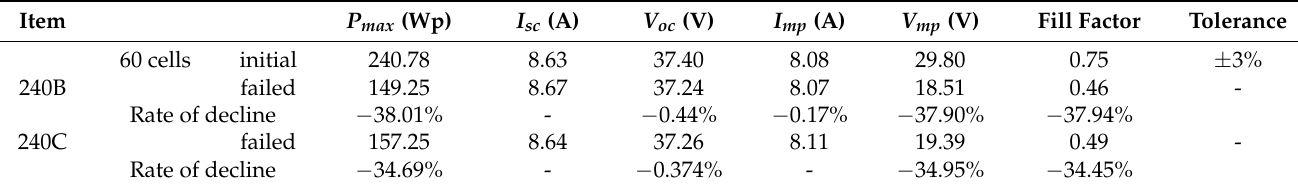
Table 2. Electrical data deviations of initial and failed modules. (240B, 240C).